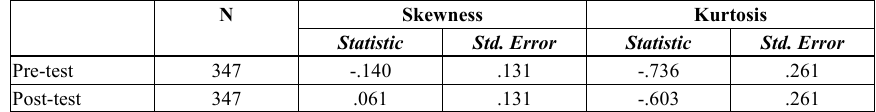
Table 2. Skewness test and Kurtosis test of the pre- and post-test data N